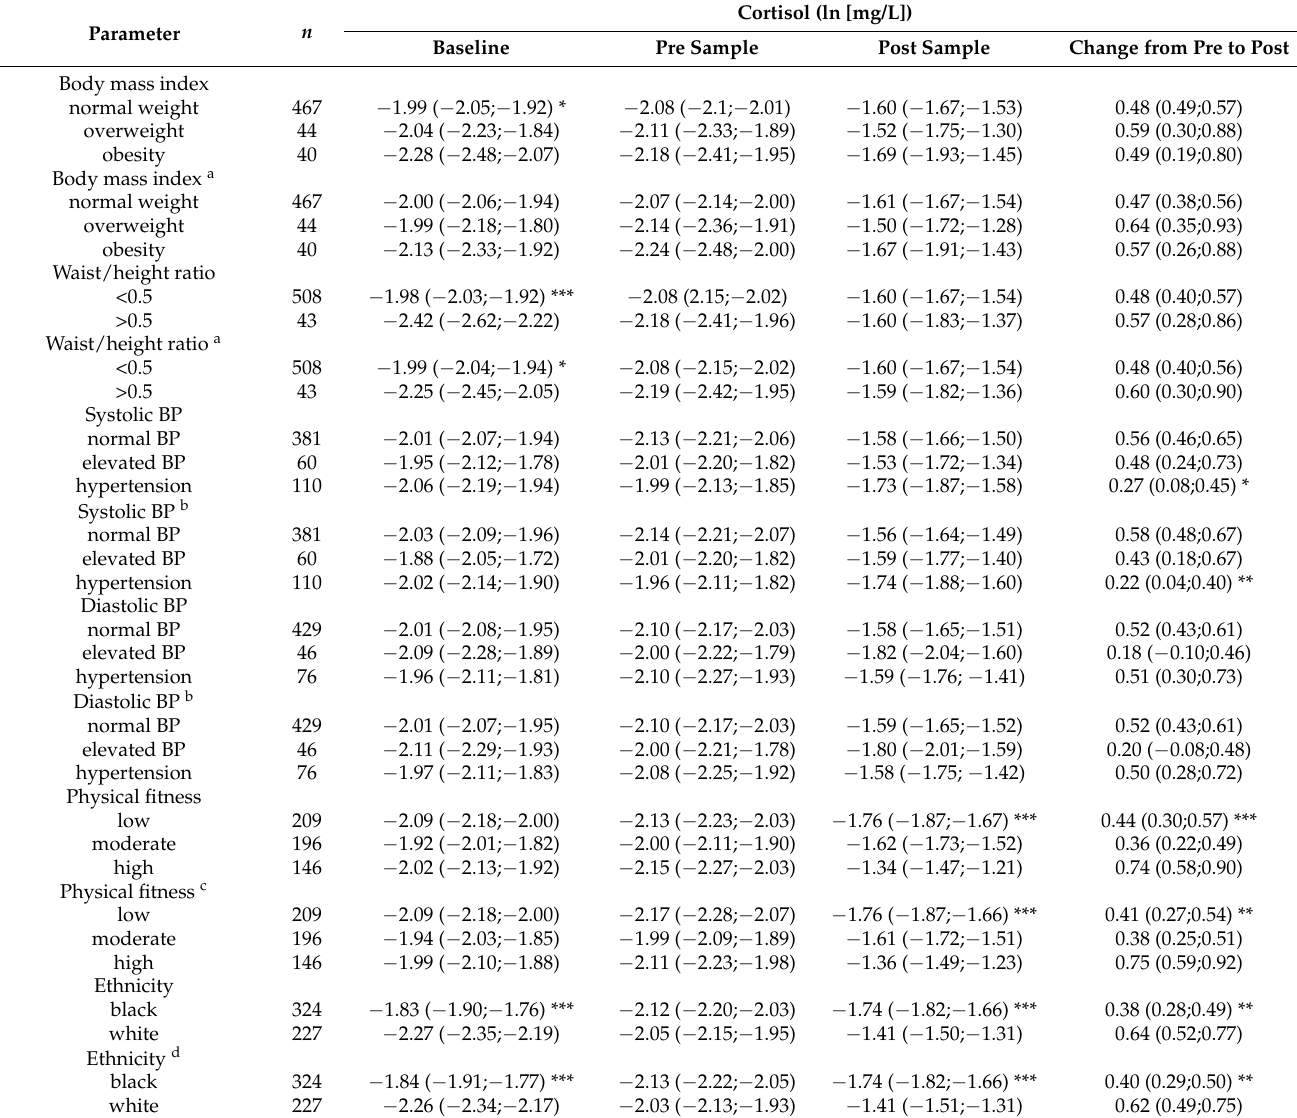
Table 2. Saliva cortisol level at baseline, before and after the cardiorespiratory fitness test and cortisol reactivity in relation to clinical categories of body mass index, waist-to-height ratio, blood pressure and tertiles of physical fitness and